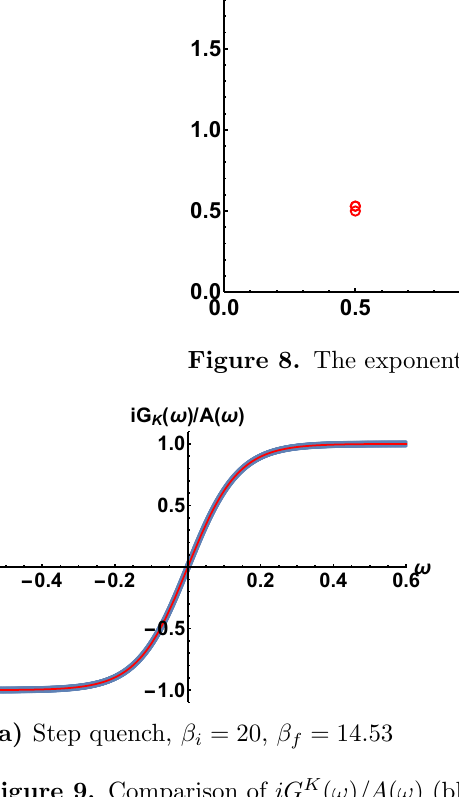
Figure 9. Comparison of iG K ( ! ) =A ( ! ) (blue dots) with tanh( (cid:12) f != 2) (thin red